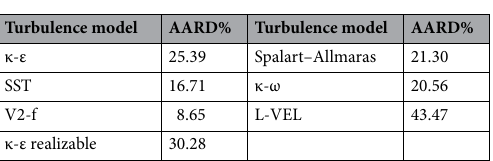
Table 3. AARD% of different turbulence models (Arina data).